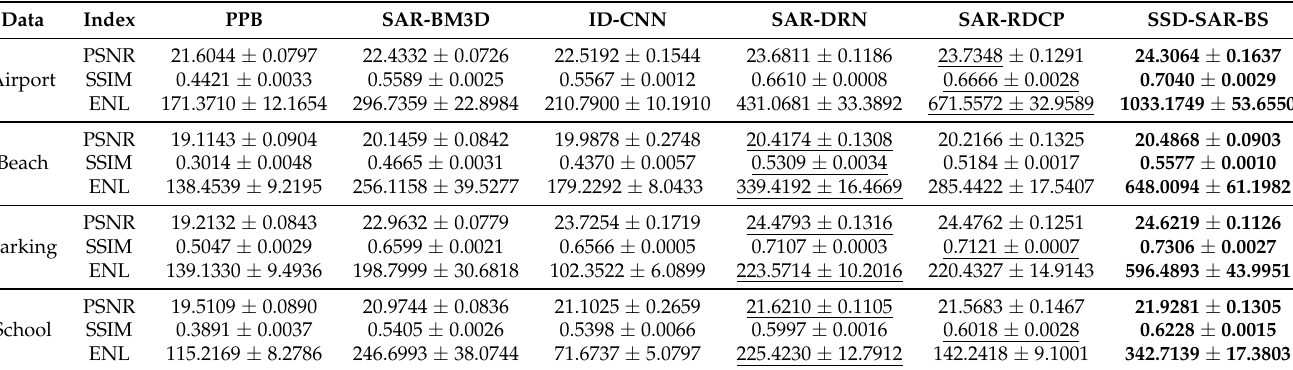
Table 2. Quantitative evaluation results on synthetic speckled